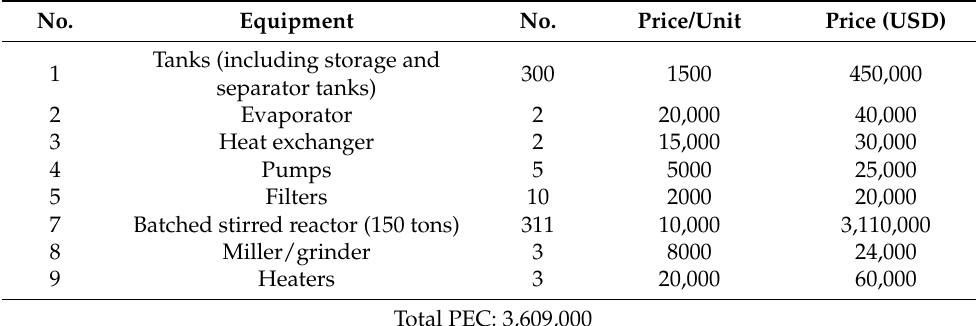
Table 4. The PEC in bioethanol